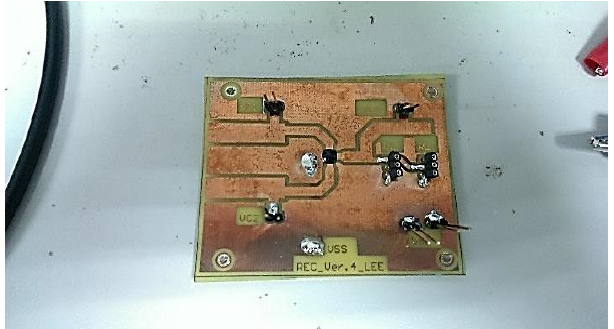
Figure 25. Secondary measurement resonance coil.